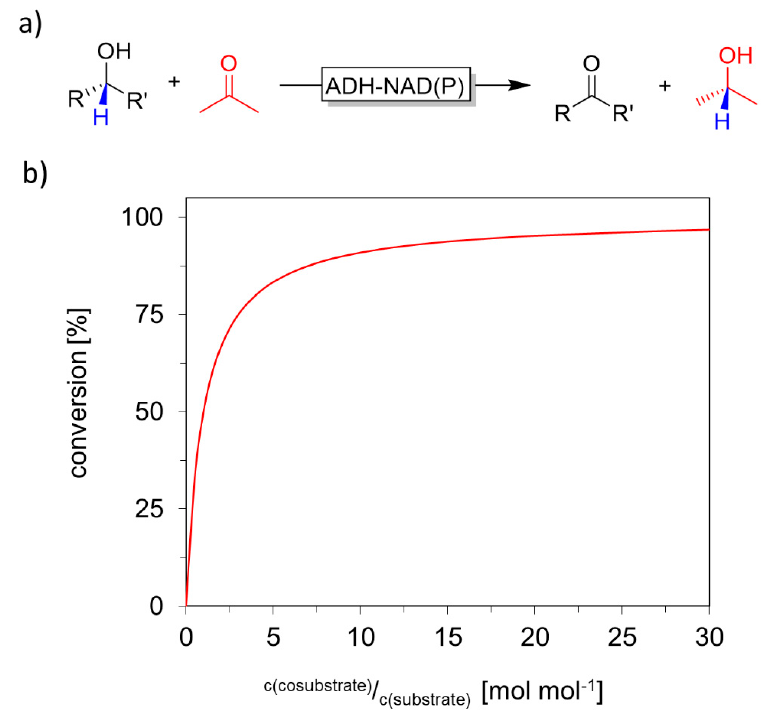
Figure 3. Substrate-coupled oxidation of alcohols. ( a ) Overall reaction using acetone as oxidant; ( b ) dependency of the equilibrium substrate conversion on the molar surplus of the cosubstrate (acetone) assuming an equilibrium constant K of 1.